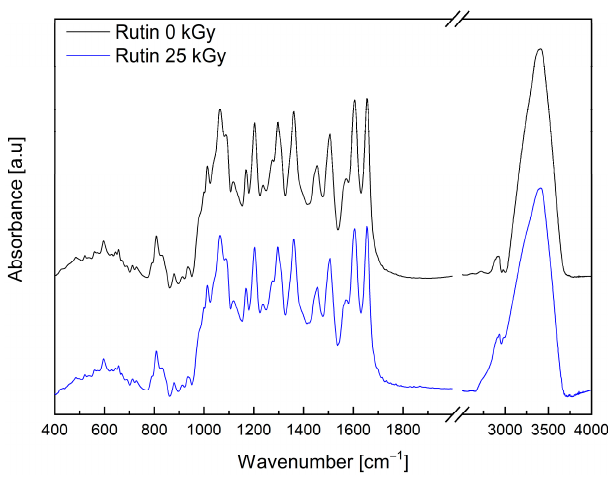
Figure 3. IR absorption spectra of non-irradiated (Rutin 0 kGy—black) and irradiated (Rutin 25 kGy—blue) rutin at room temperature, range from 400 to 4000 cm − 1 .